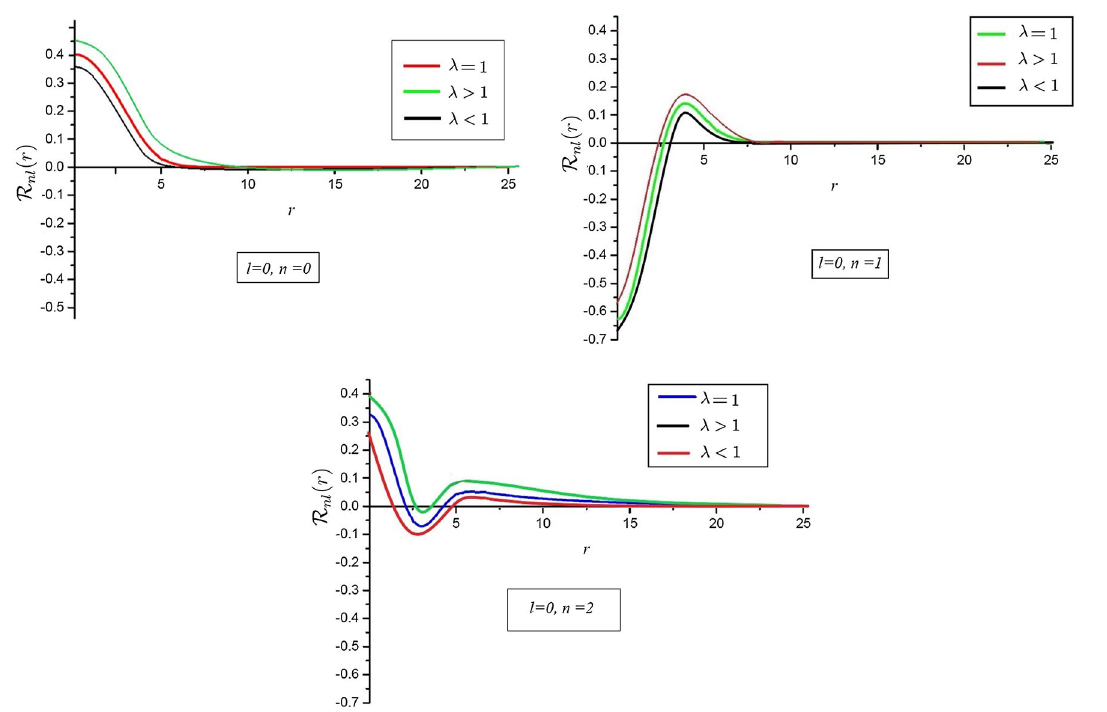
l = 0 , n = 1. The bottom plot corresponds l = 0 , n = 2. In each plot, we have plotted the wave functions for λ = 1 , ≥ 1 , ≤